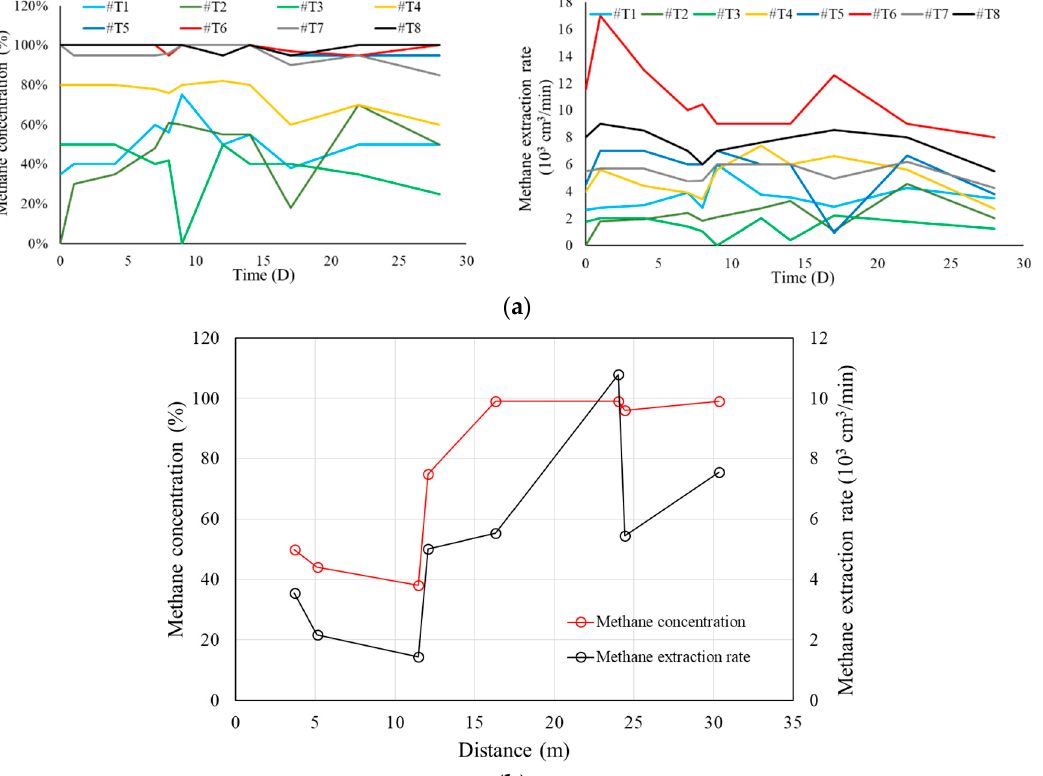
Figure 11. Location relationship between test boreholes and the #8 fracturing borehole.